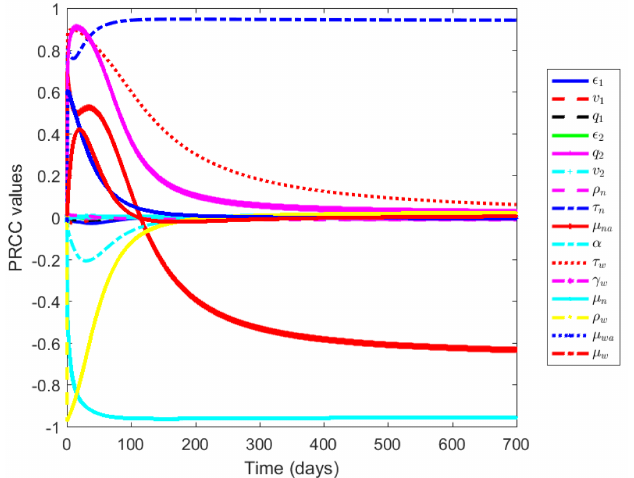
Figure 5. PRCC indices when measured against an increasing number of susceptible non- Wolbachia mosquito population in the presence of vaccination and Wolbachia